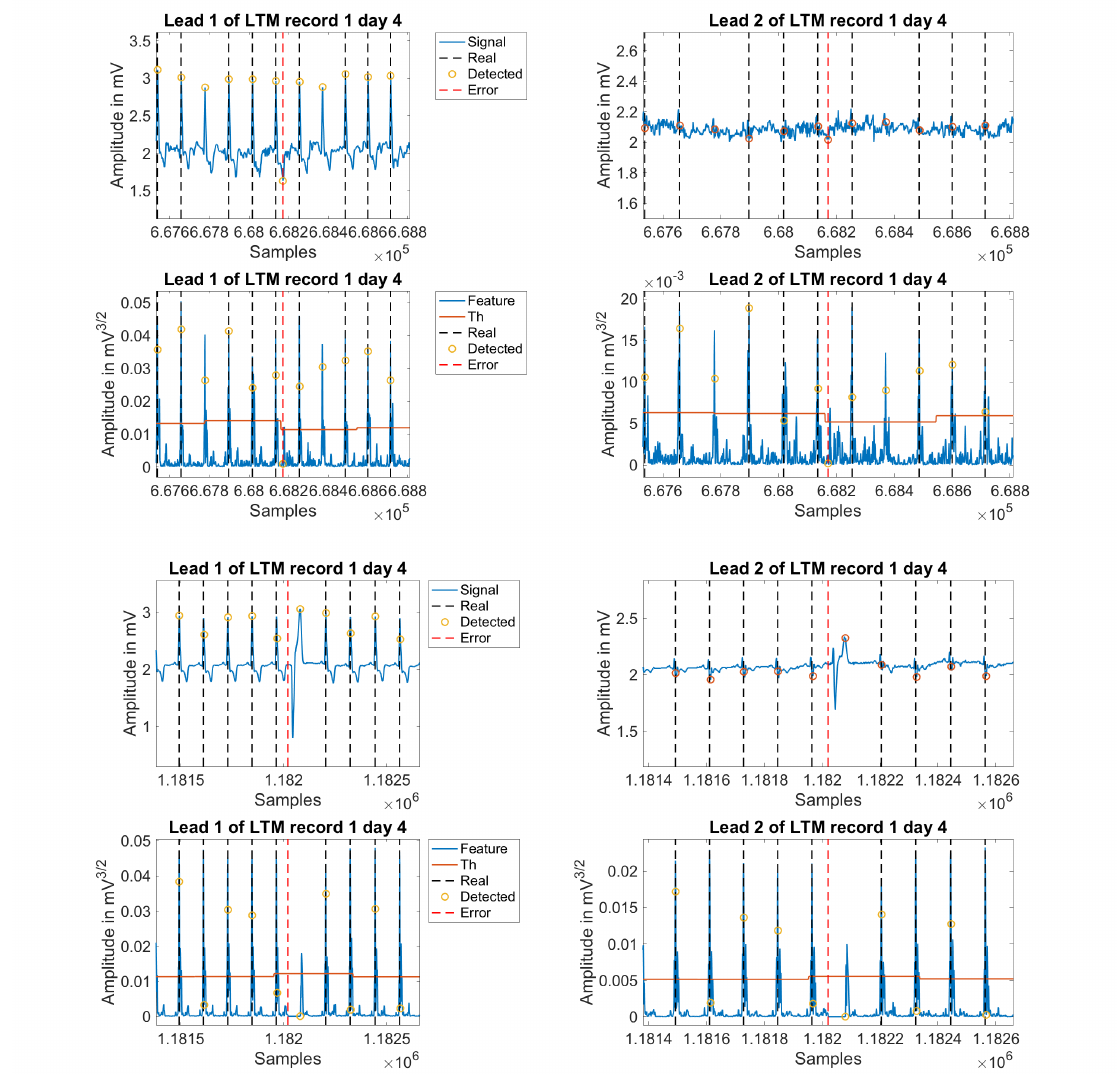
Figure 10. Example of beat miss-detection in proposed algorithm on 7-day Holter recording. The panels in the first row show leads 1 and 2 for an example of algorithm miss-detection, the second row shows the feature signal for the leads plotted before. The last four panels follow the same scheme for other algorithm miss-detection